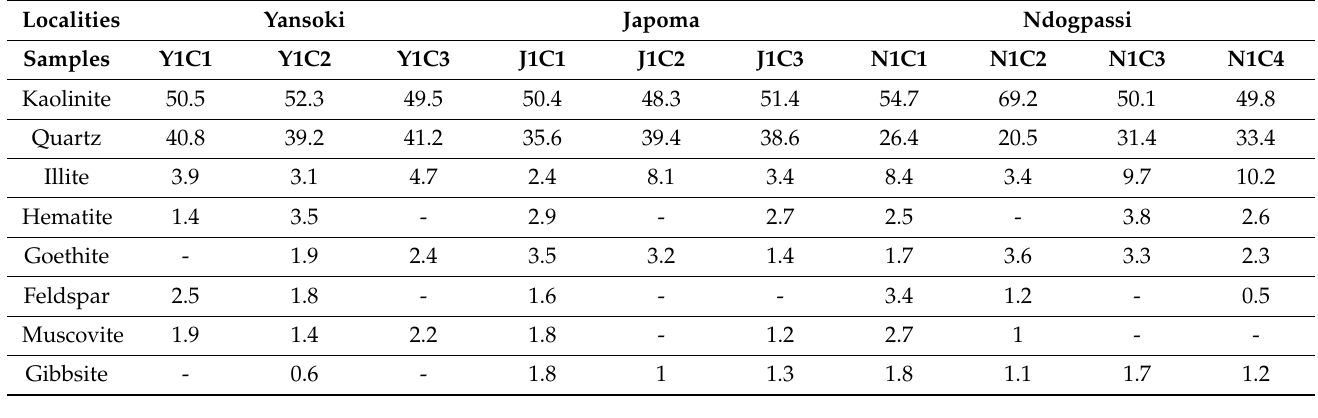
Table 1. Semi-quantitative estimation of the mineralogical composition (%) of clay materials of the eastern part of the Douala sub-basin based on peak intensities of XRD patterns.